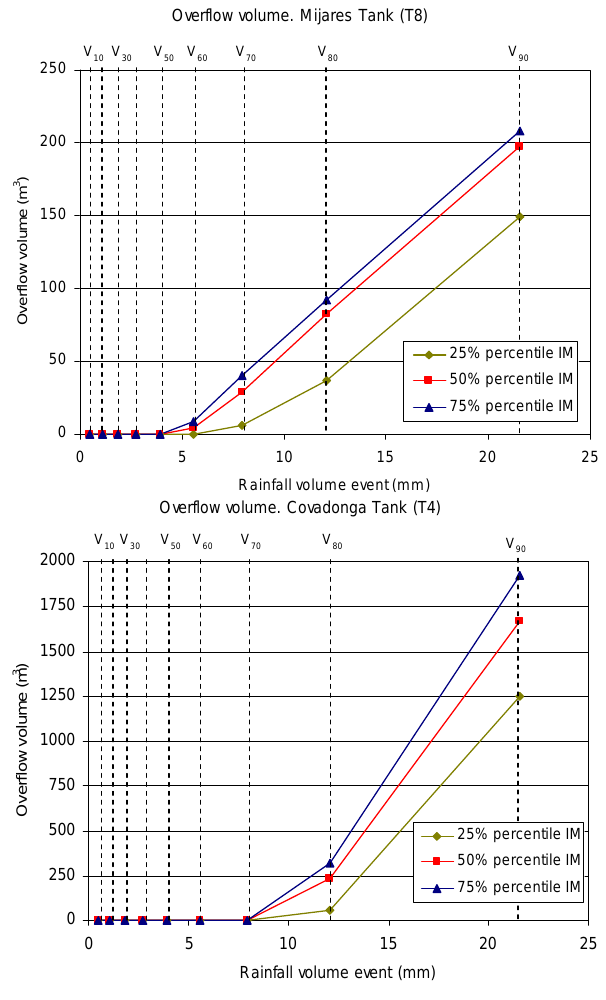
Fig. 5. Storage system diagnosis: spilled volume.